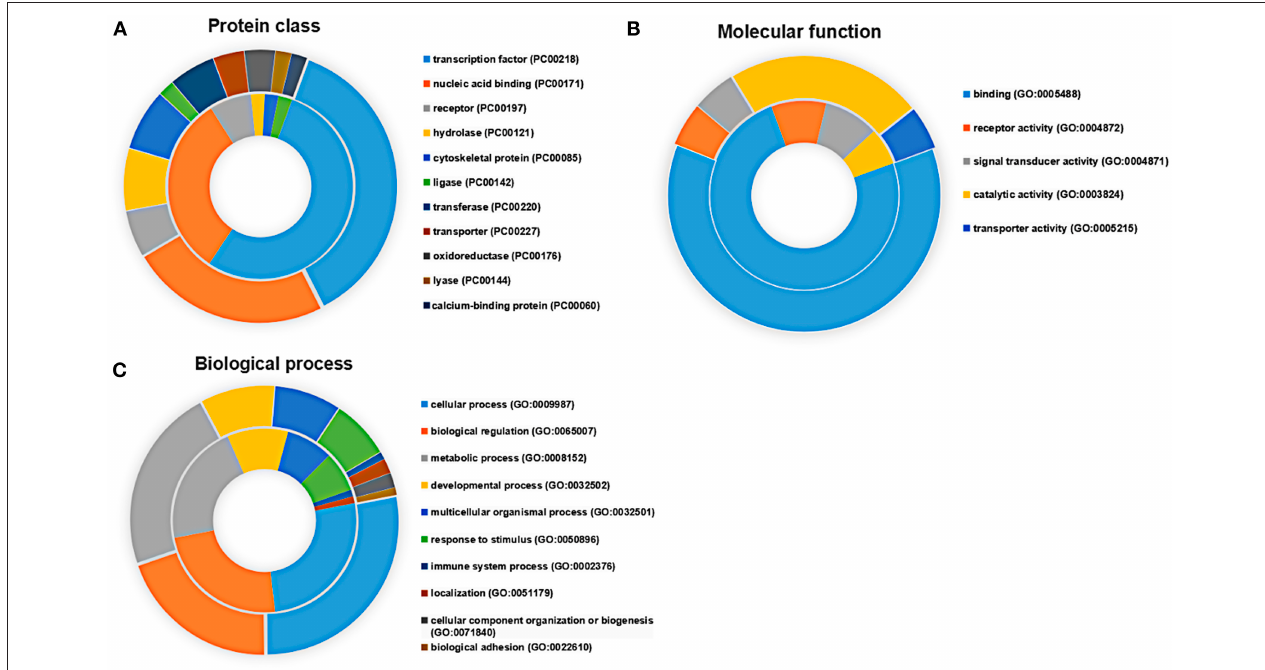
FIGURE 3 | Functional distribution of the SPI (inner circle) and CPI (outer circle) Protein candidates were classified according to their (A) protein class, (B) molecular function, and (C) biological process using the PANTHER classification system ( Mi et al., 2007) with default settings. Gene symbols were used as input.